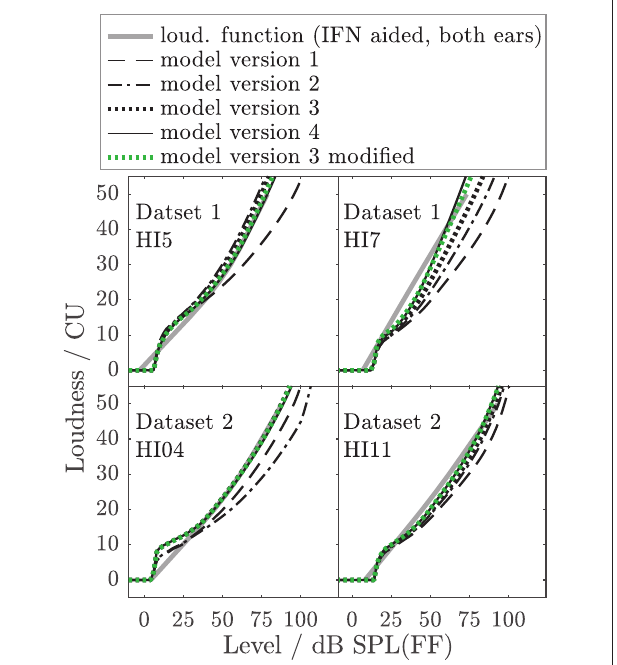
FIGURE 10 | Examples of empirical loudness functions for aided binaural IF noise (solid gray lines) of listeners HI05 and HI07 of Dataset 1 (also shown in Figures 6 , 7 ) and two listeners of Dataset 2 (HI04 and HI11), together with the respective predictions of all individualized model versions indicated in the